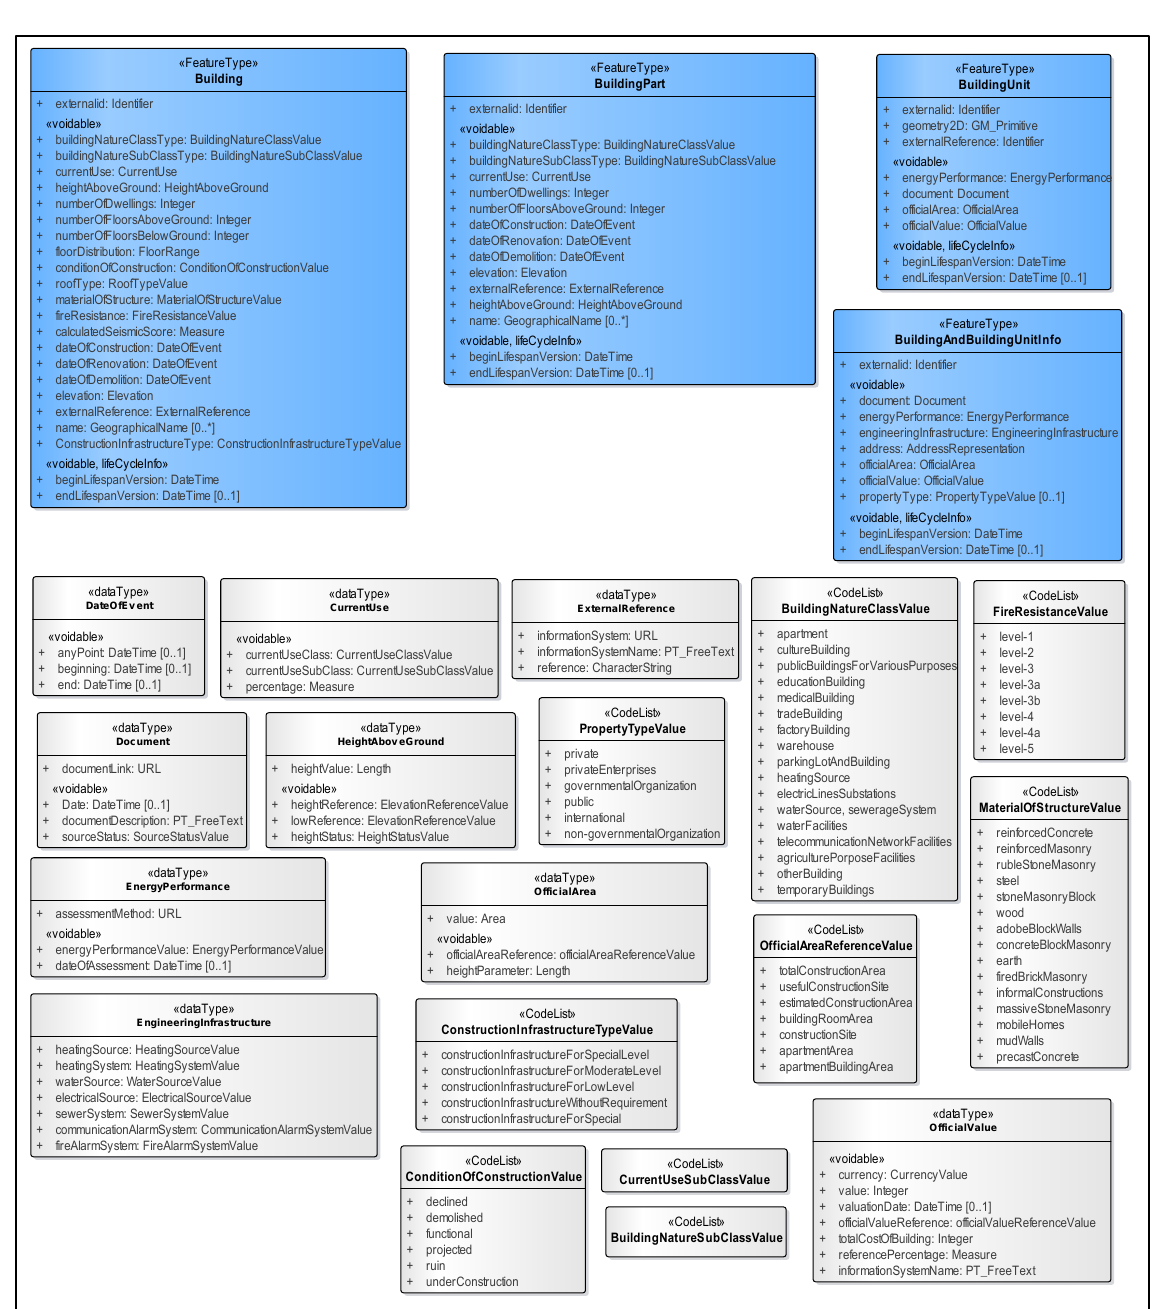
Figure 7. Basic data model of building construction standard. Table 2. Short description of UML class, datatype and code list of building construction standard.